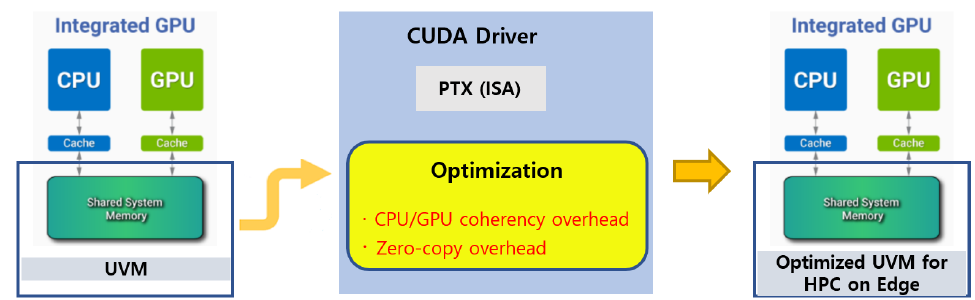
Figure 2. UVM (Unified Virtual Memory) optimization of the CUDA model for HPC on